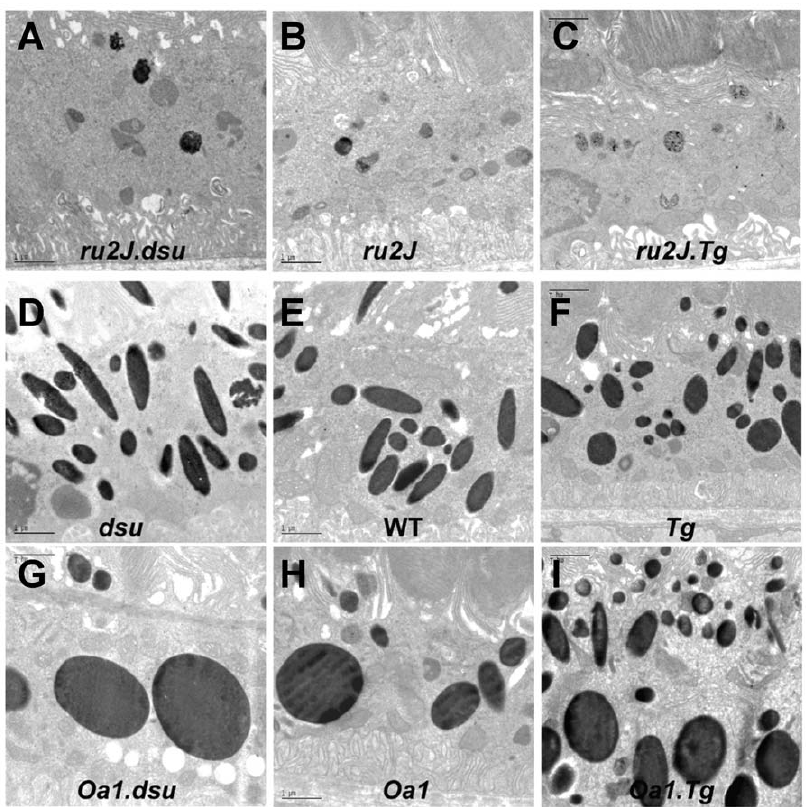
Figure 2. Size, shape, and density of melanosomes in the RPE of Hps and Oa1 loss of function mouse mutants are altered by loss or overexpression of melanoregulin. A–I: Electron microscopic images of the RPE in mice of the genotypes indicated. Orientation is with photoreceptor outer segments toward the top and Bruch’s membrane/choroid toward the bottom of each image. Abbreviations: ru2J=Hps5 ru2J ; dsu=Mreg dsu ; WT=wildtype; Tg=Mreg Tg ; Oa1=Oa1 ko . Scale bar=1 m m.